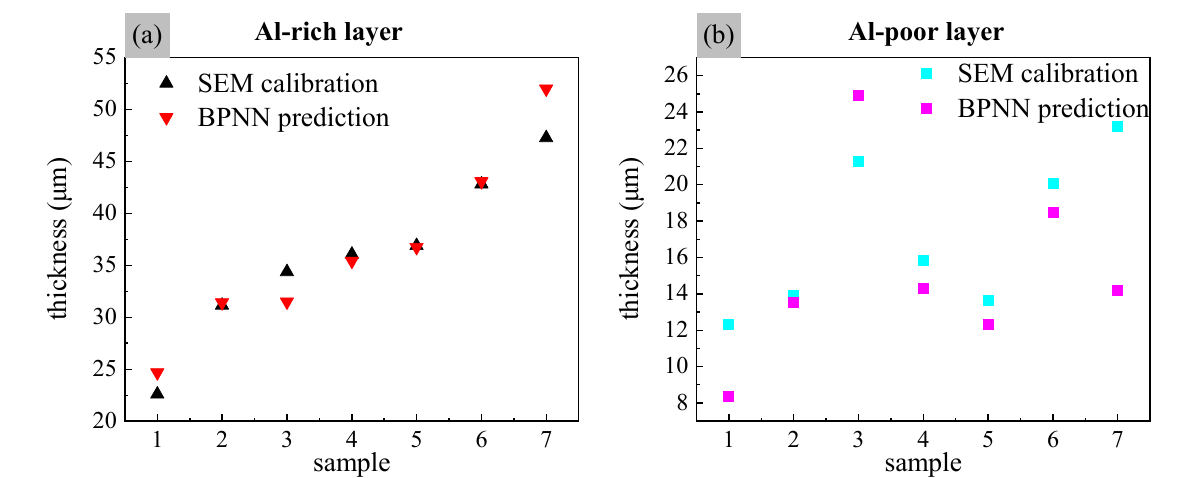
Figure 8. Comparison of calibrated and predicted values. ( a ) Al-rich layer thickness comparison; ( b ) Al-poor layer thickness